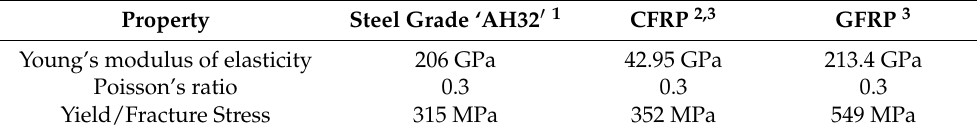
Table 1. Material properties for steel, CFRP, and GFRP.